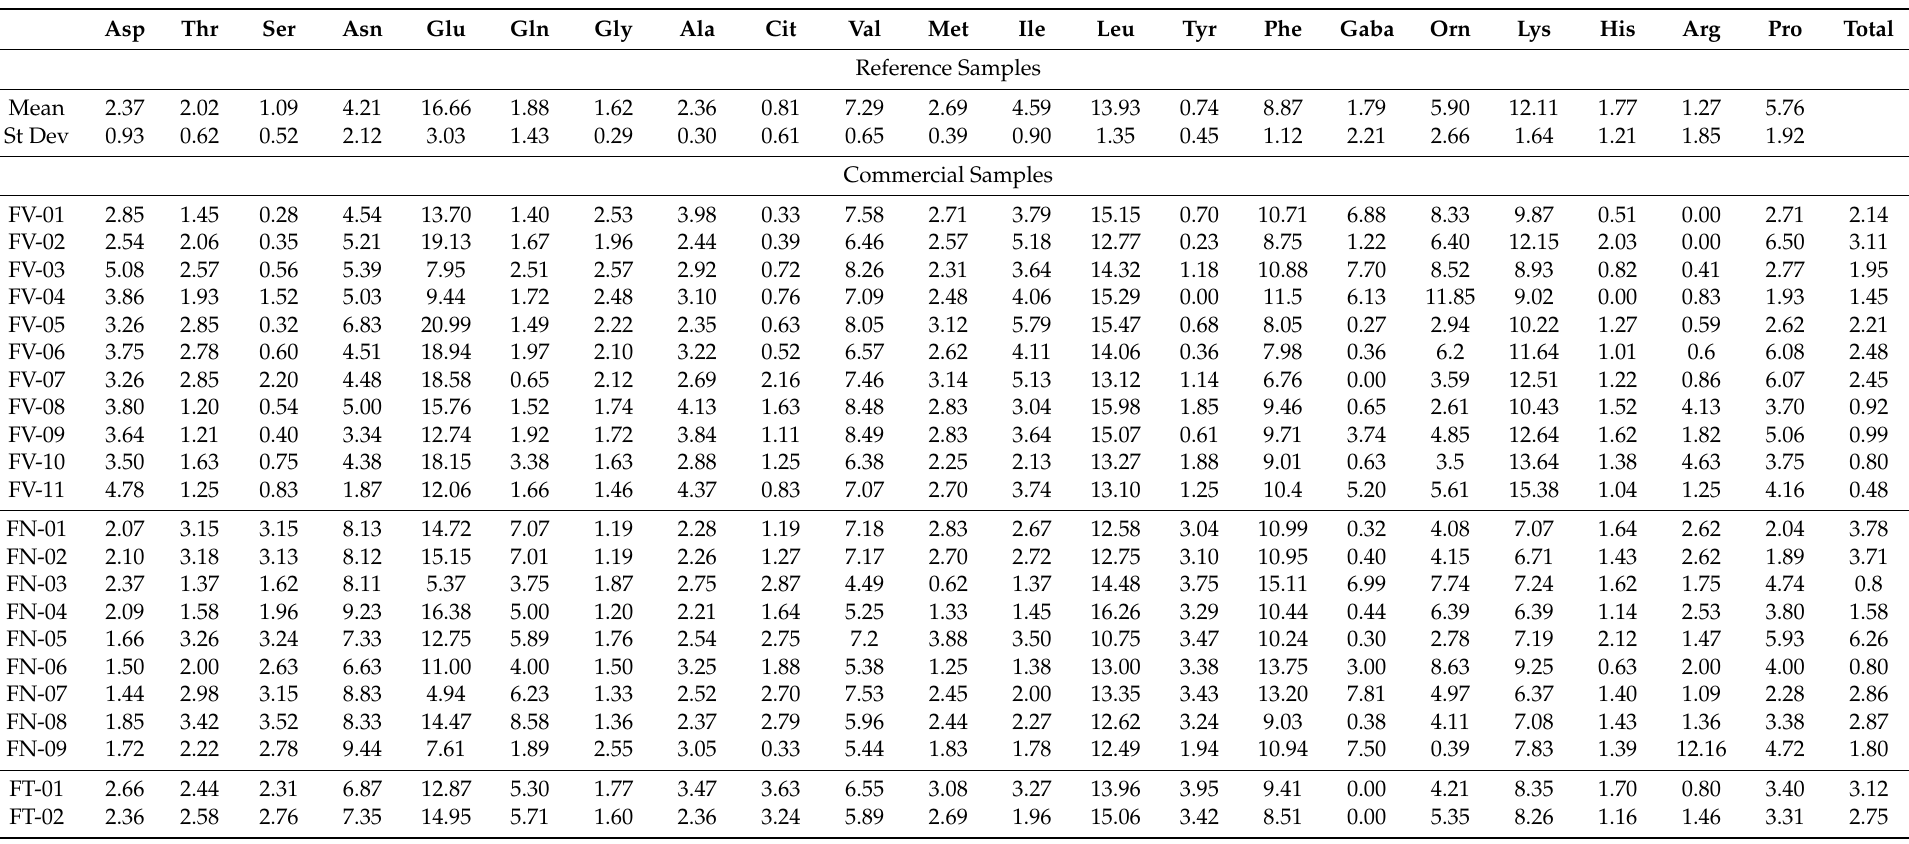
Table 2. Free amino acid content (as relative percent) of reference samples of Fontina PDO cheese ( n = 41) and commercial samples of Fontina PDO (FV), Fontal (FN) and traditional Fontal